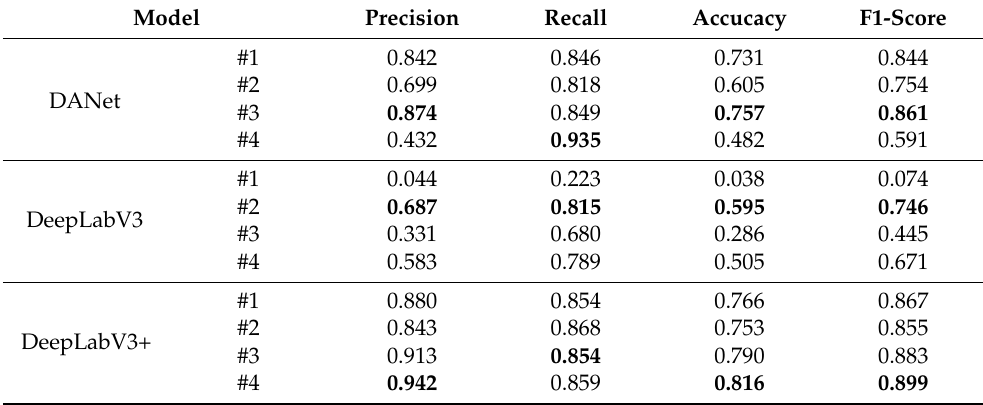
Table 1. Summary of crack segmentation model performance.